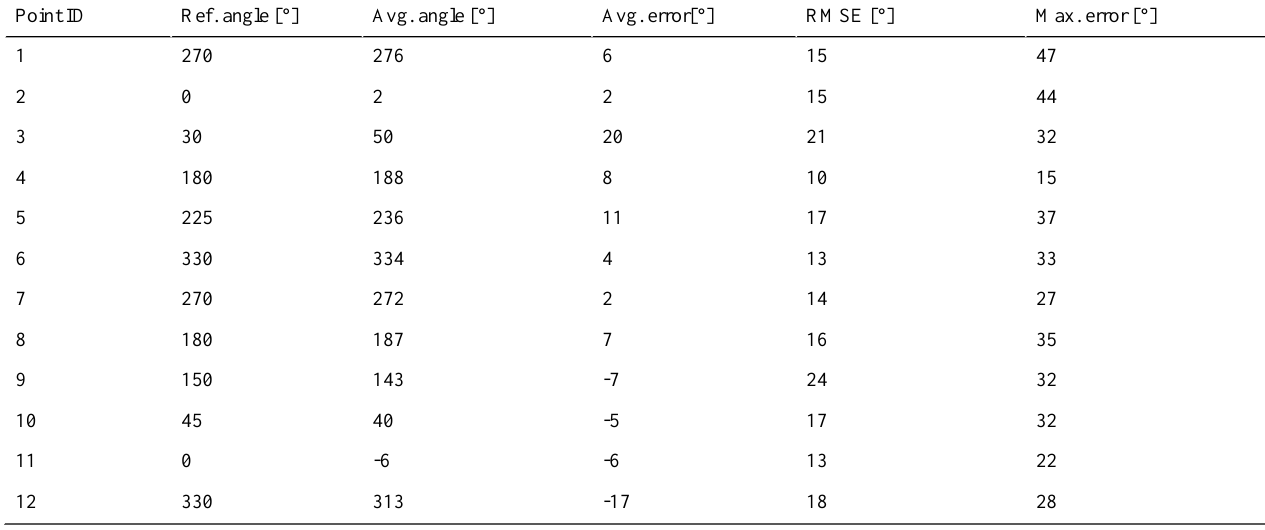
Table 4. Statistical results aggregated per marker point for orientation estimation using vision based classification and the GROE algorithm (Method2) with the smartphone on the hip